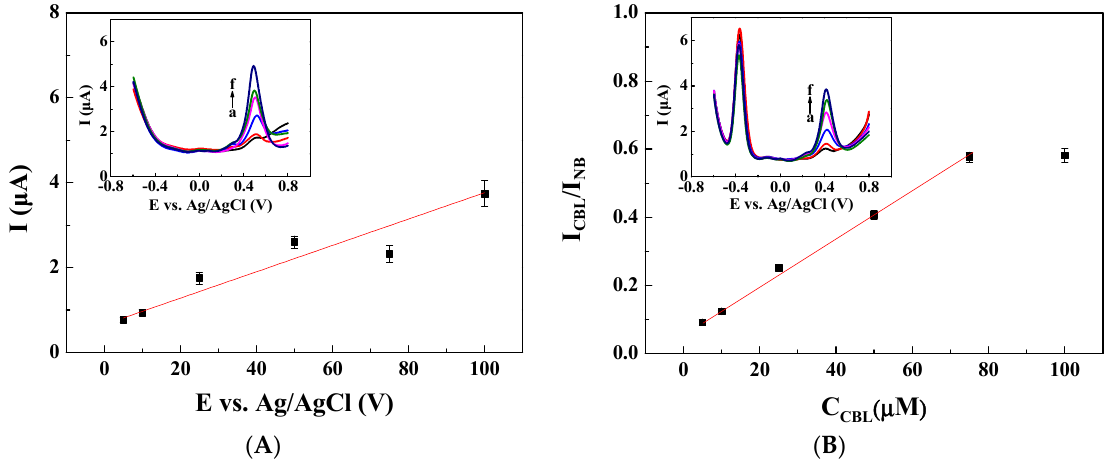
Figure 4. ( A ) Calibration curves of CBL using single-signal strategy on bare GCE; ( B ) Calibration curves of CBL using dual-signal strategy on bare GCE. Inset: SWV curves of various concentration of CBL. Error bars: SD; n = 3.